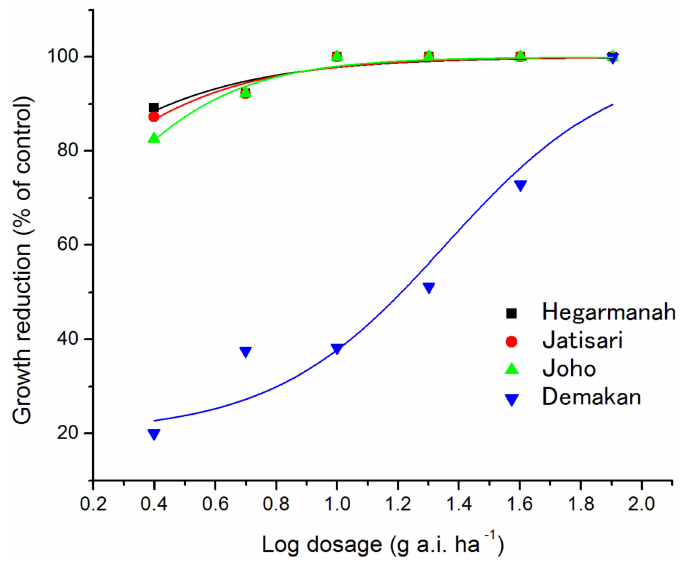
Figure 3. Growth reduction curves of four populations of L. decurrens against penoxsulam dose. Table 2. Herbicide dose required for 50% reduction (GR 50 ) of dry biomass and resistance index.